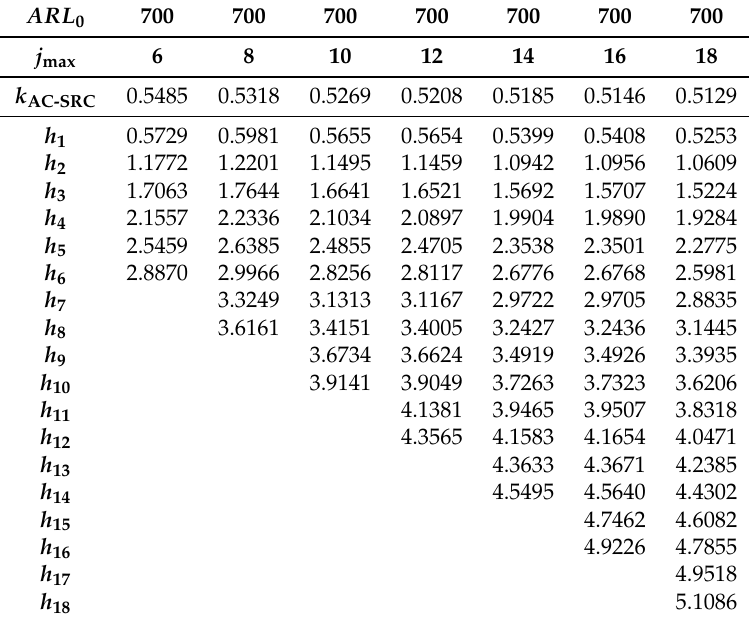
Table A8. AC-SRC for ARL 0 = 700.